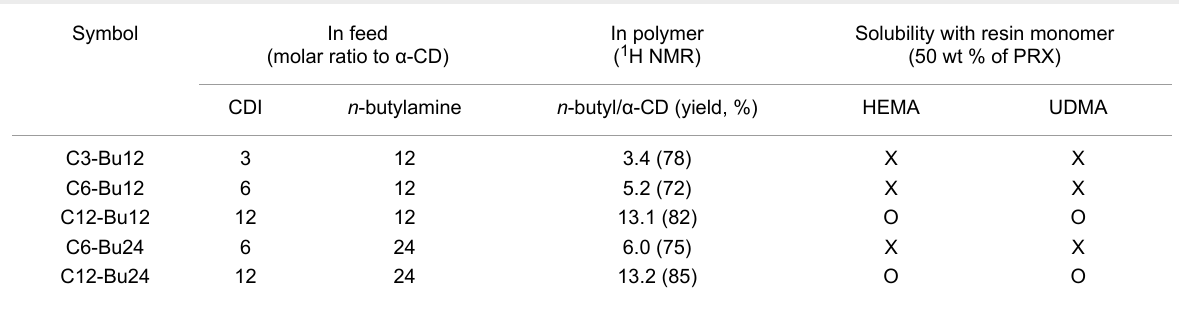
Table 1: Molecular profiles of the n -butyl-modified PRXs. Symbol In feed (molar ratio to α